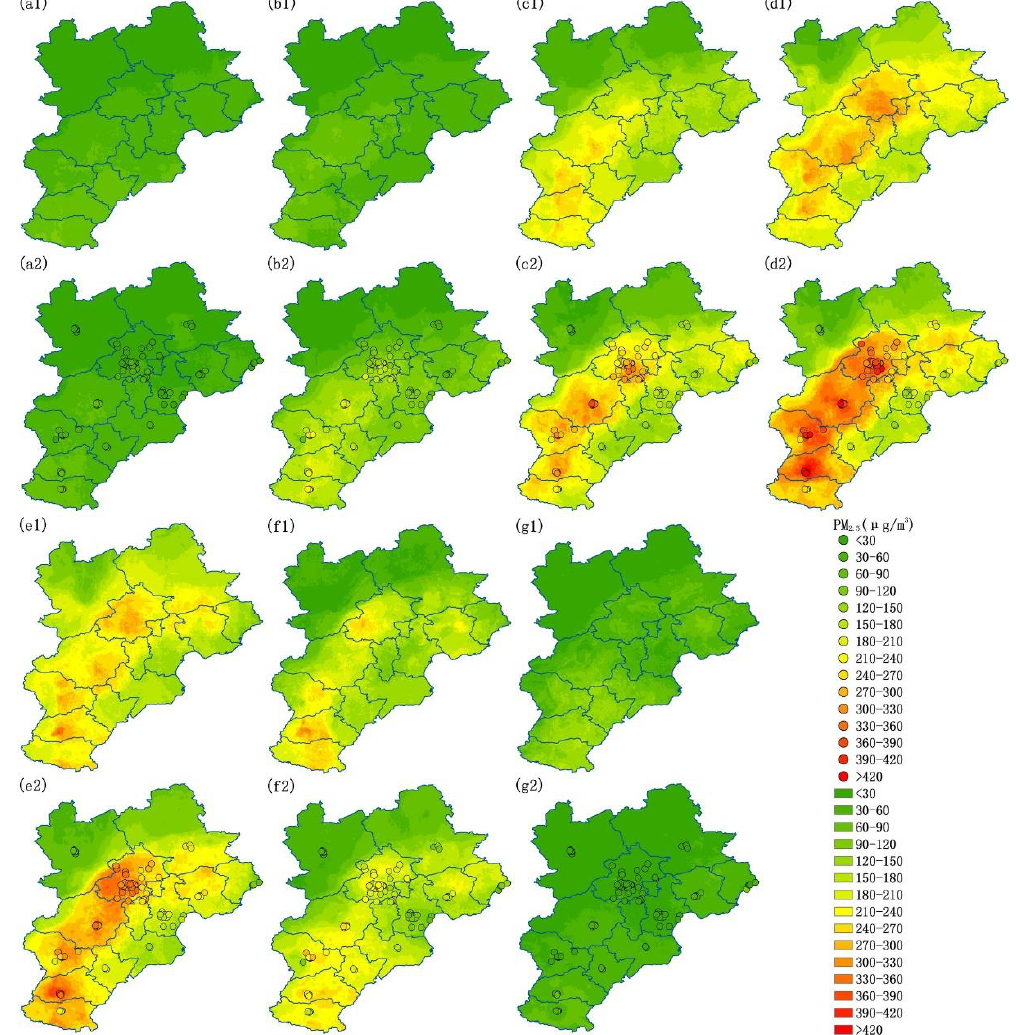
Figure 6 . +1-day PM2.5 prediction results from October 6, 2014 to October 12, 2014. (a1)–(g1) show the +1-day PM2.5 prediction results; (a2)–(g2) show the PM2.5 inversion results and the site monitoring PM2.5